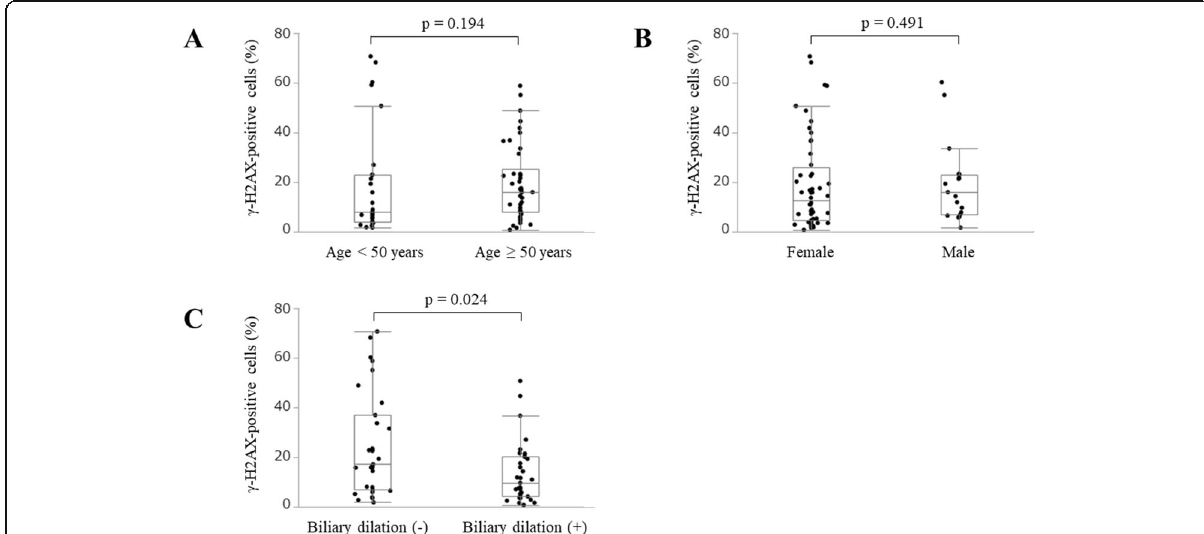
Fig. 4 Associations between the degree of γ -H2AX expression and clinical characteristics. There were no significant differences for ( A ) age or ( B ) sex. C The expression of γ -H2AX was significantly higher in cases without biliary dilation than in those with dilation ( p = 0.024). γ -H2AX, phosphorylated H2AX at